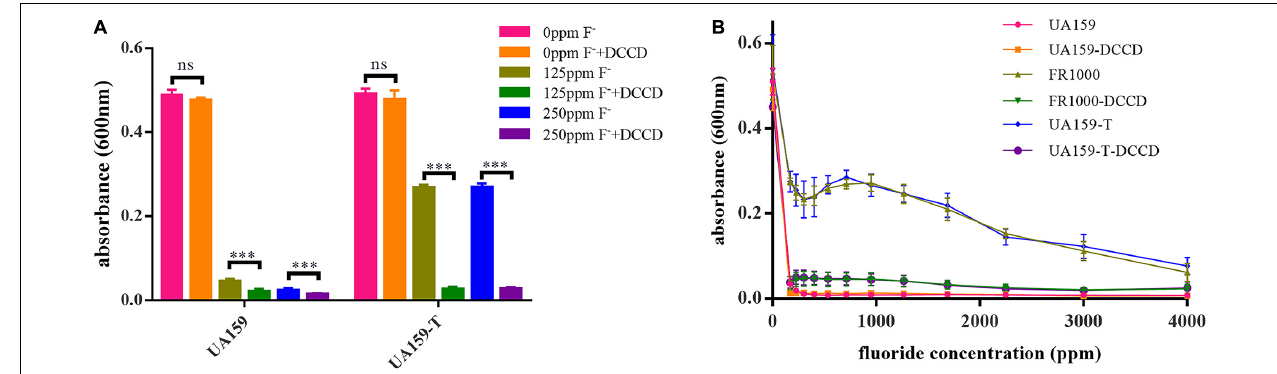
FIGURE 3 | Effects of Dicyclohexylcarbodiimide (DCCD), a specific F 0 F 1 -ATPase inhibitor, on fluoride resistance of S. mutans . (A) Fluoride inhibitory assays with 200 µ M DCCD: suppression of the F 0 F 1 -ATPases by DCCD increased fluoride susceptibility of the fluoride-resistant strains in fluoride environment. The significance level ( α ) was set at 0.05 (independent two-sample t -test, two-tailed test, IBM SPSS Statistics 24). *** indicates P < 0.001. ns indicates no significant difference. N = 8 per group. (B) Effects of gradient-concentration fluoride treatment with 200 µ M DCCD on S. mutans growth ( N = 12 per group and per fluoride concentration): 200 µ M DCCD suppressed F 0 F 1 -ATPases, increased fluoride susceptibility of the fluoride-resistant strains, and reversed the resistance effects induced by F 0 F 1 -ATPase over-expression.